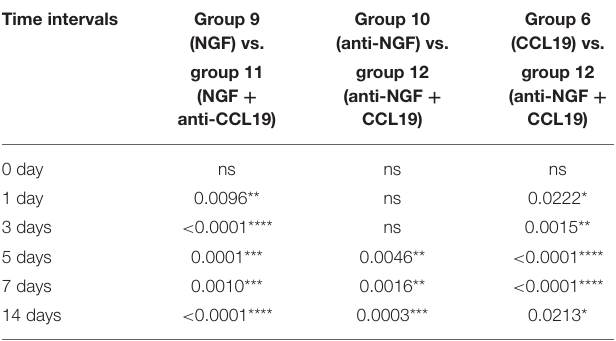
TABLE 3 | p -value of bite force of rats over time after injection of CCL19/NGF-related reagents. Time intervals Group 9 Group 10 (NGF) vs. (anti-NGF)